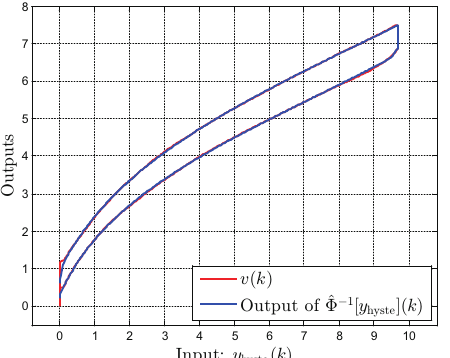
Figure 5. Comparison of the responses of the directly identified inverse model ˆ Φ − 1 [ y hyste ]( k ) with the measured nonlinearities.